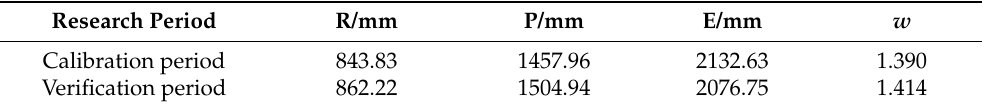
Table 11. Changes in water yield, meteorology and characteristic parameters of the underlying surface of the basin during the base period and the change period.